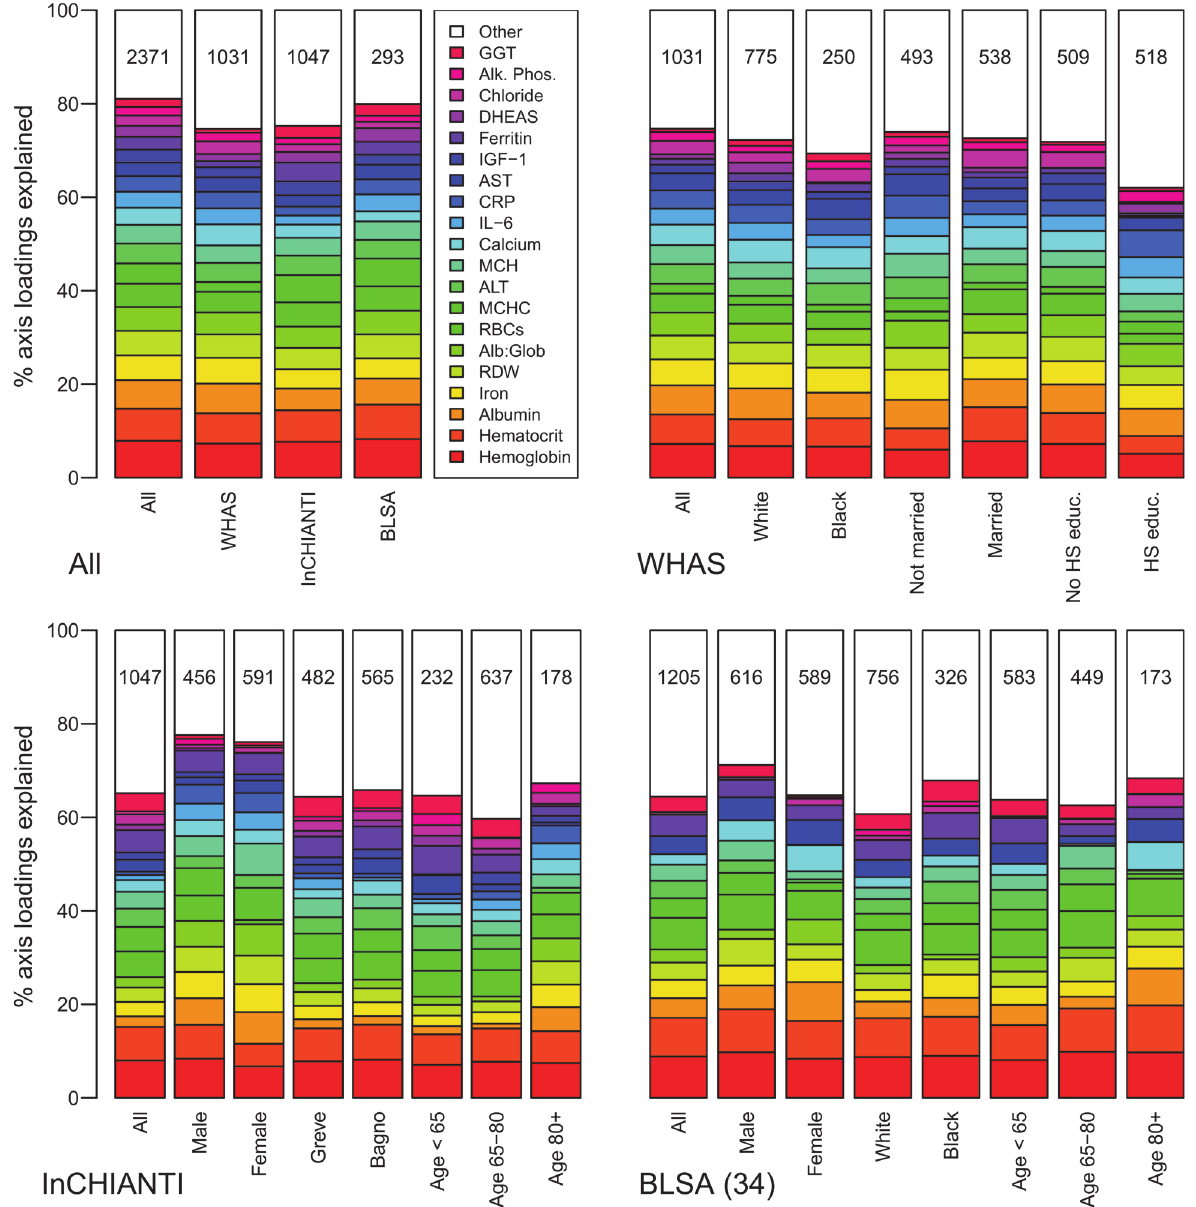
Fig 7. Age-adjusted biomarker loading order and stability for PCA1 across data sets and subsets. Loading importance is calculated as the loading divided by the sum of the absolute values of all loadings. These values are ordered from high (red, on bottom) to low (magenta, on top) for the first 20 loadings; remaining loadings are grouped together as “ Other ” in white. Accordingly, hemoglobin has the strongest loading, then hematocrit, then albumin, etc. The order and colors are derived from the full analysis combining the first visits of individuals in all three data sets (top-left panel, left column, “ All ” ) and applied to all other columns in the figure. Stability of loadings is indicated by conservation of loading heights across bars. For each panel, the loadings for the full data set are at left. Numbers indicate subset sample sizes. For all panels except BLSA, the 43-variable set is used; for BLSA there was insufficient sample size to perform PCA on subsets with 43 variables, so the 34-variable analysis is